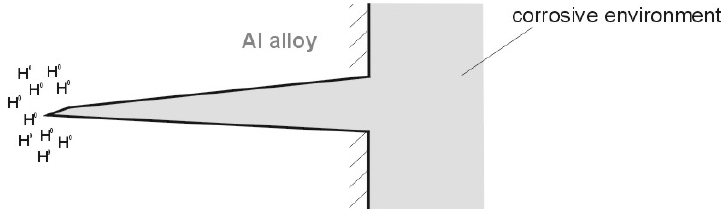
Figure 3. Stress corrosion cracking—distribution of hydrogen absorbed by the metal (or metal alloy).